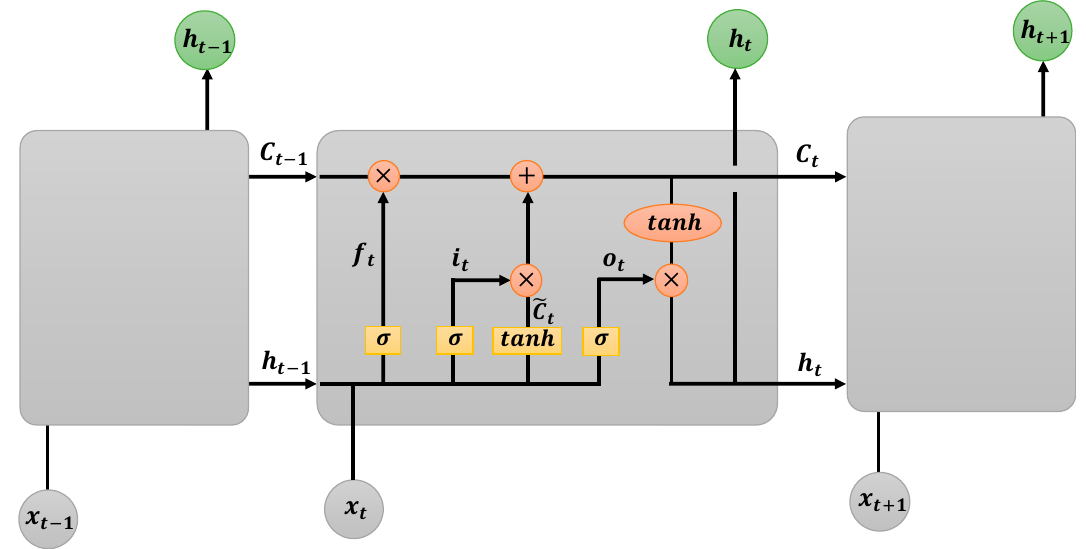
Figure 5. Structural Diagram of LSTM based on EMG Biometric Signals.